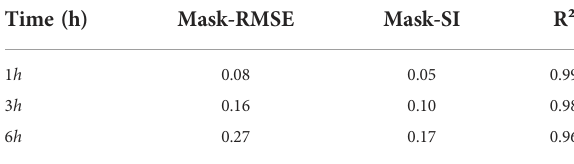
TABLE 1 The evaluation metrics of the model at different forecast